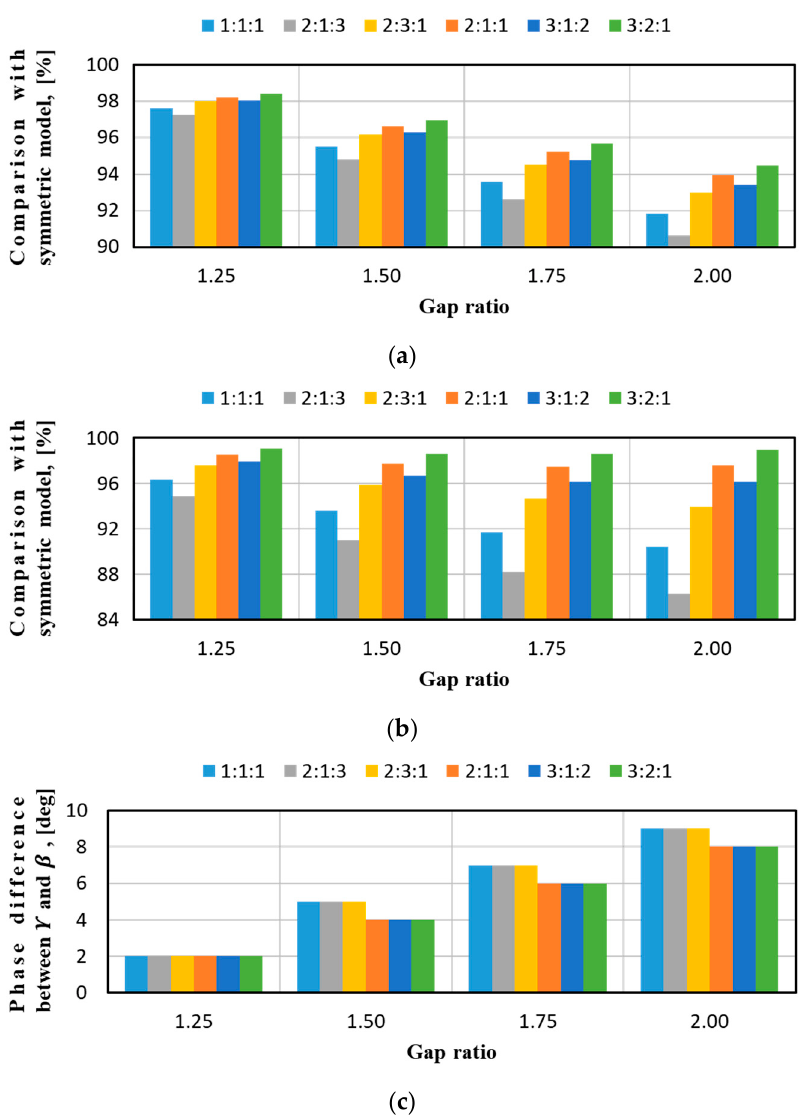
Figure 5. No load performance of stepped air gap according to ratio of length and angle: ( a ) back- electromotive force; ( b ) cogging torque; ( c ) phase difference between back-EMF and cogging torque.